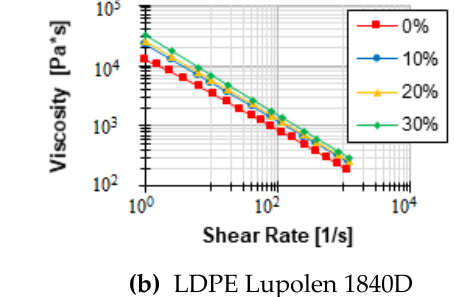
Figure 9. Comparison of the relative viscosities of different models over the solids contents.